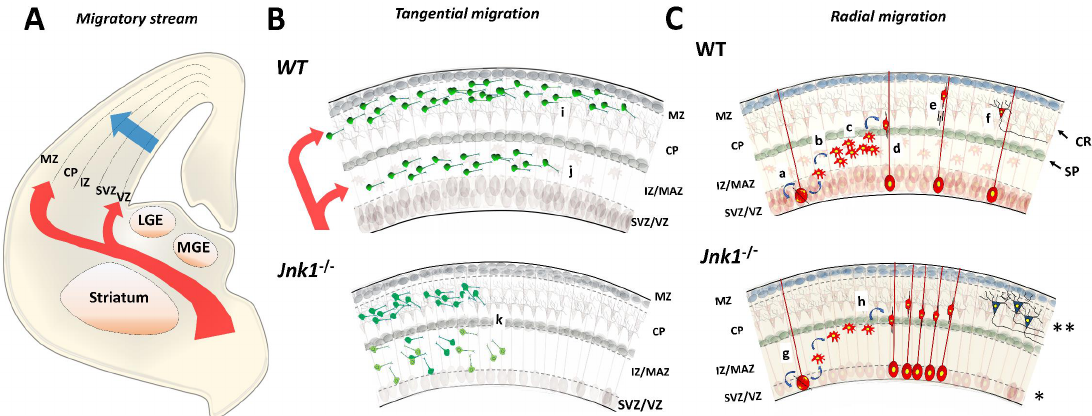
Figure 4. E ff ects of genetic Jnk1 disabling in the neuronal migration process during cortical embryonic development in mice. ( A ) Cortical glutamatergic neurons born in the lateral ventricles (blue). Cortical interneurons born in the GE (Red) ( B ) Interneurons from MGE (green) reach the corticostriatal junction at E12 and invade the subpallium. Interneurons enter to the developing cortex lateromedially following two migratory tangential streams (i, j). The (i) stream populates the superior layer, while the (j) stream populates deep layers and hippocampus. Jnk1- / - mice experience severe alterations due to a delay of entrance and erratic migration of cortical interneurons (k). ( C ) RG-like cells (red) self-renew and proliferate by symmetric division: (a-b) RG cells undergo asymmetric division and become migratory multipolar neurons. (c) Multipolar cells accumulate in IZ and form the MAZ. (d) Multipolar cells migrate towards the SP and seize radial processes to climb through them toward the pia. They acquire bipolar morphology. (e) Radial migration ceases and (f) neurons populate the upper (2 / 3 and 4) and deep (5 and 6) layers. This radial migration process is altered in Jnk1- / - mice at E18 of development. The multipolar-to-bipolar phase is faster than in wild-type (WT) (g to h versus a to d). The ventricular zone is smaller (*) and the cortical layers are disordered